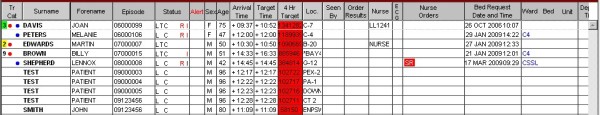
Part of EDIS’ main clinical screen.